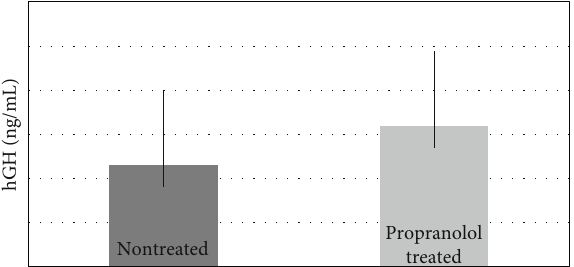
Figure 2: Mean hGH level in propranolol-treated (6.38 ng/mL) versus non-treated hemangioma patients (4.59 ng/mL). SD =3.15 ng/mL, p = 0 : 16